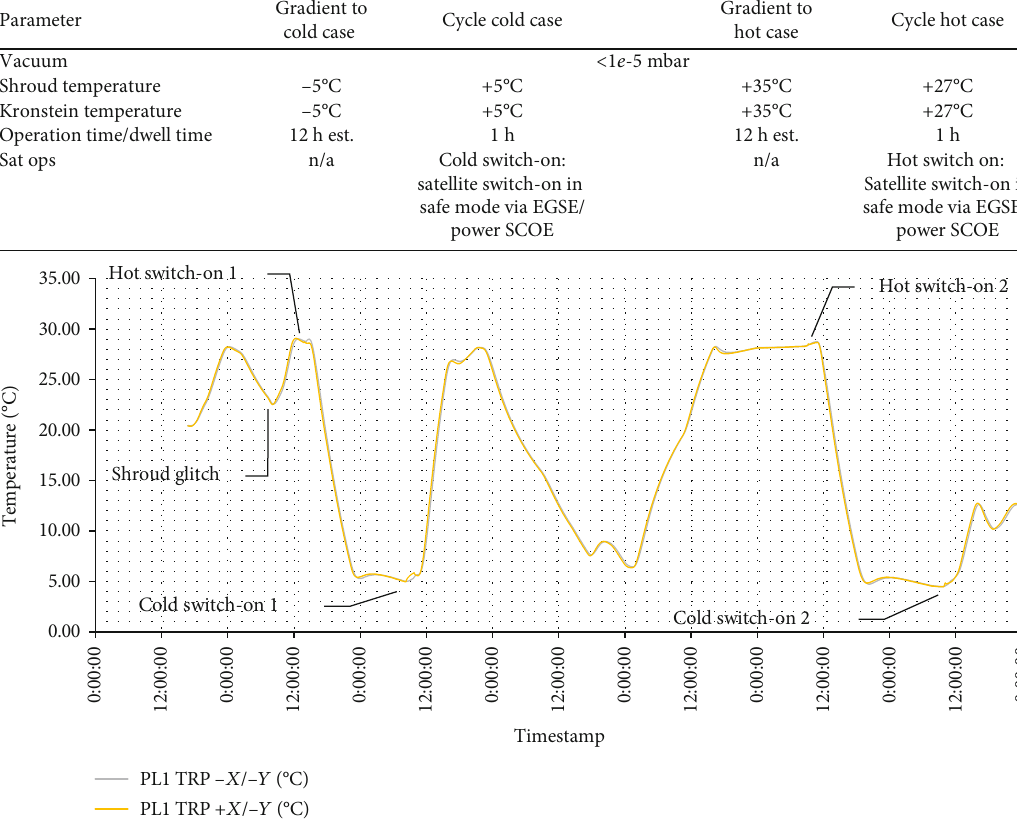
Figure 12: Eu:CROPIS thermal vacuum test — setting and result